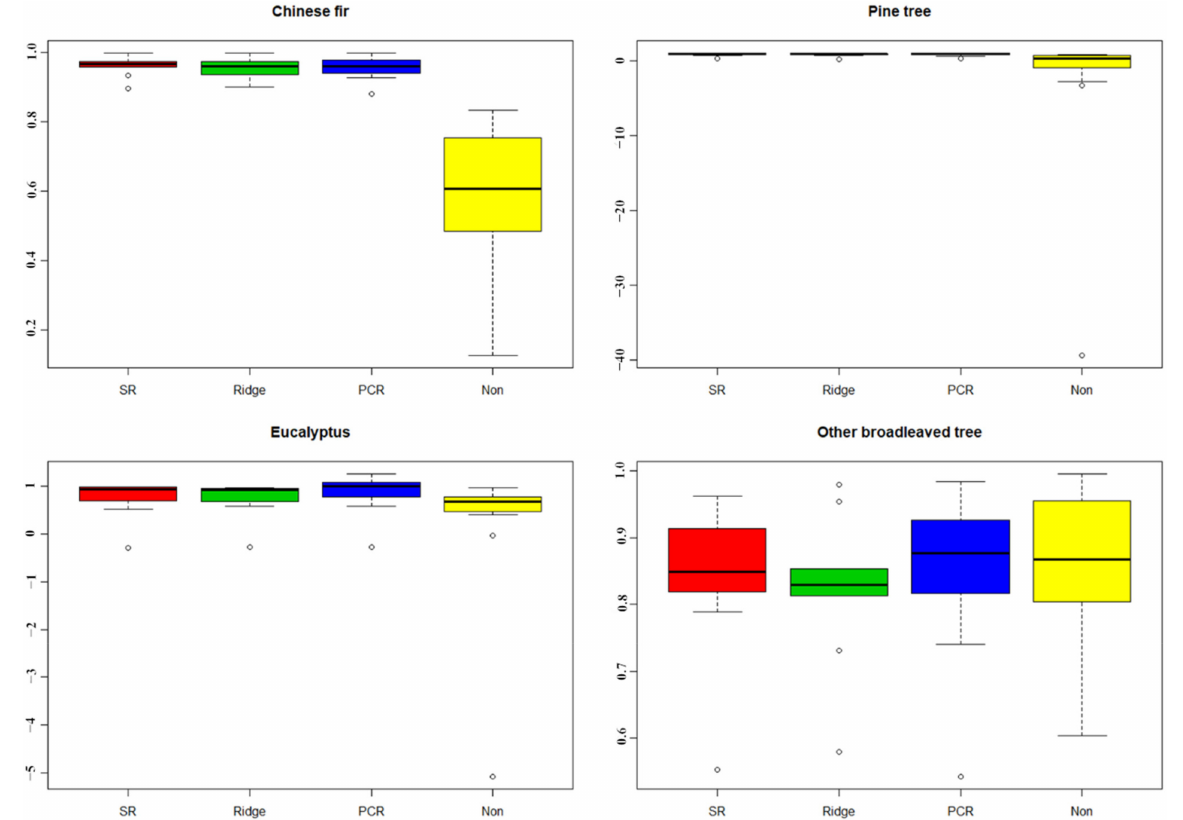
Figure 5. Box diagram of four models’ accuracy A for each tree species. Table 9. Accuracy A comparison of four models for each tree